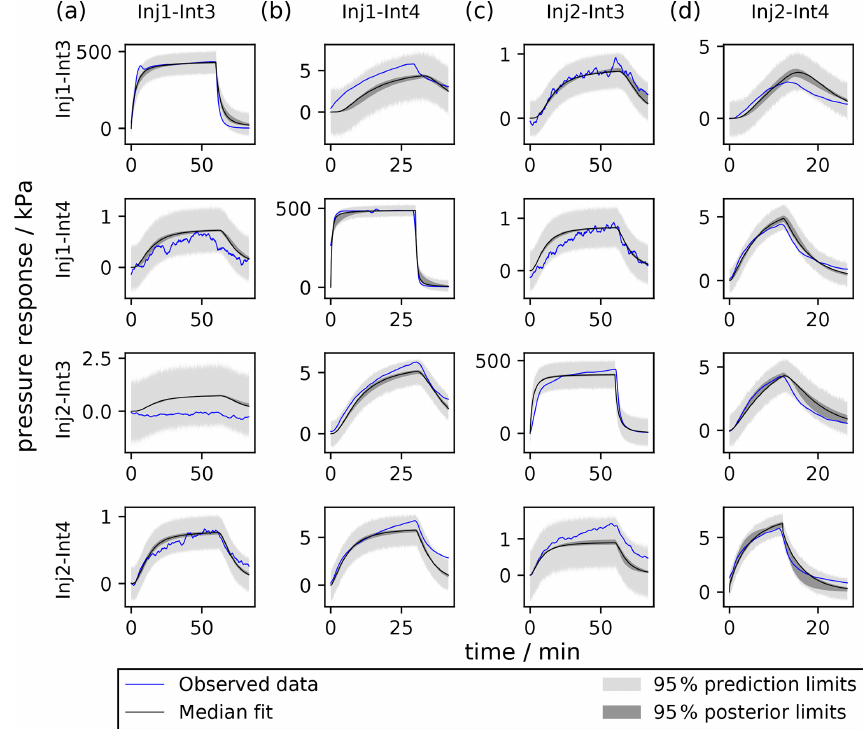
Figure 5. Comparison of the observed pressure response with the simulation of the hydraulic tomography experiment for the posterior DFN realizations for injection in the intervals Inj1–Int3 (a) , Inj1–Int4 (b) , Inj2–Int3 (c) , and Inj2–Int4 (d) , according to Table 1. For visual clarity, the observed pressure signals have been